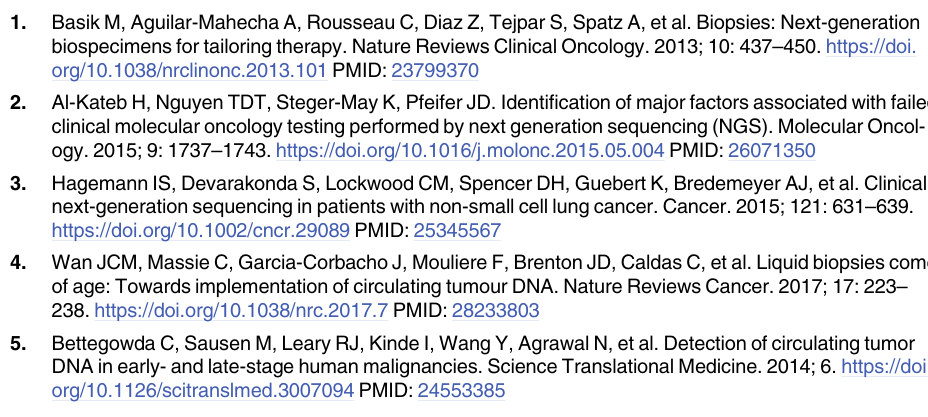
S9 Table. EGFR variants detected by LiquidHALLMARK and cobas EGFR Mutation Test v2. S1 File. Minimal data set for